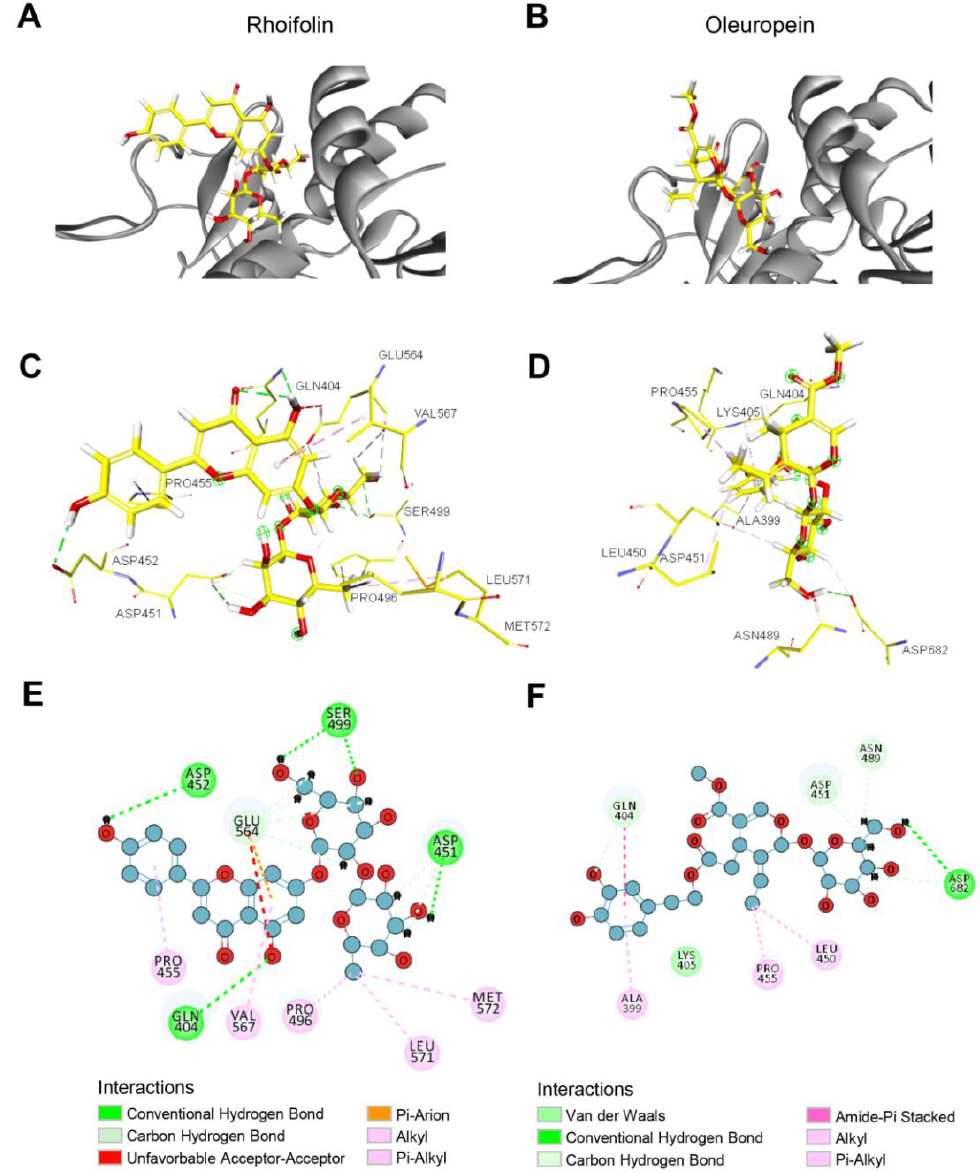
Figure 5. The predicted position of Rhoifolin and Oleuropein in the binding pocket of eEF2K. ( A , B ) The predicted binding mode of Rhoifolin ( A ) and Oleuropein ( B ) with eEF2K. ( C , D ) Ligand interactions of Rhoifolin ( C ) and Oleuropein ( D ) with eEF2K residues. ( E , F ) 2D interaction diagram of Rhoifolin ( E ) and Oleuropein ( F ) with eEF2K residues.